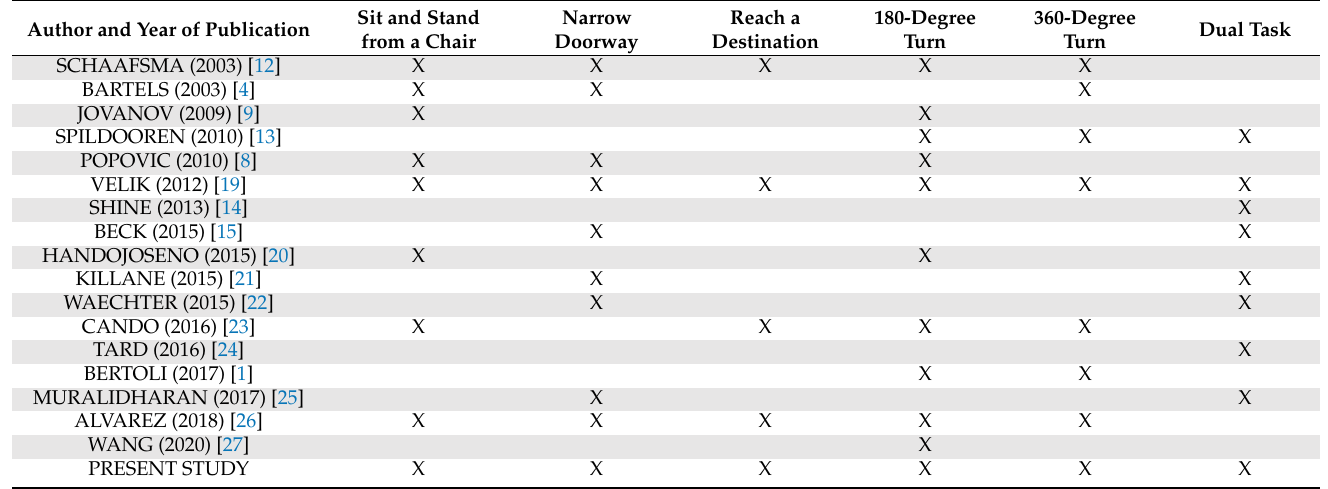
Table 1. Papers included in the literature review with triggers that are able to cause FOG episodes.